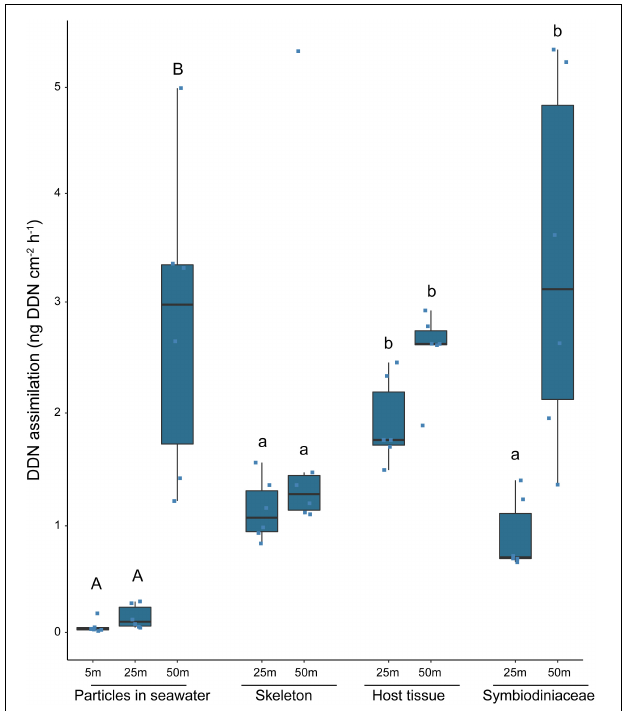
FIGURE 1 | DDN assimilation rates in particles of the incubation water and in the different compartments of Stylophora pistillata corals from three different water depths in winter. Values from the three coral compartments at 5 m in winter and values from summer are not shown as no DDN assimilation was detected there. Different lettering above the bars indicates significant differences between the particles in seawater (A, B) and separately between the three coral compartments (a, b) (Generalized Linear Models; significance level: p <